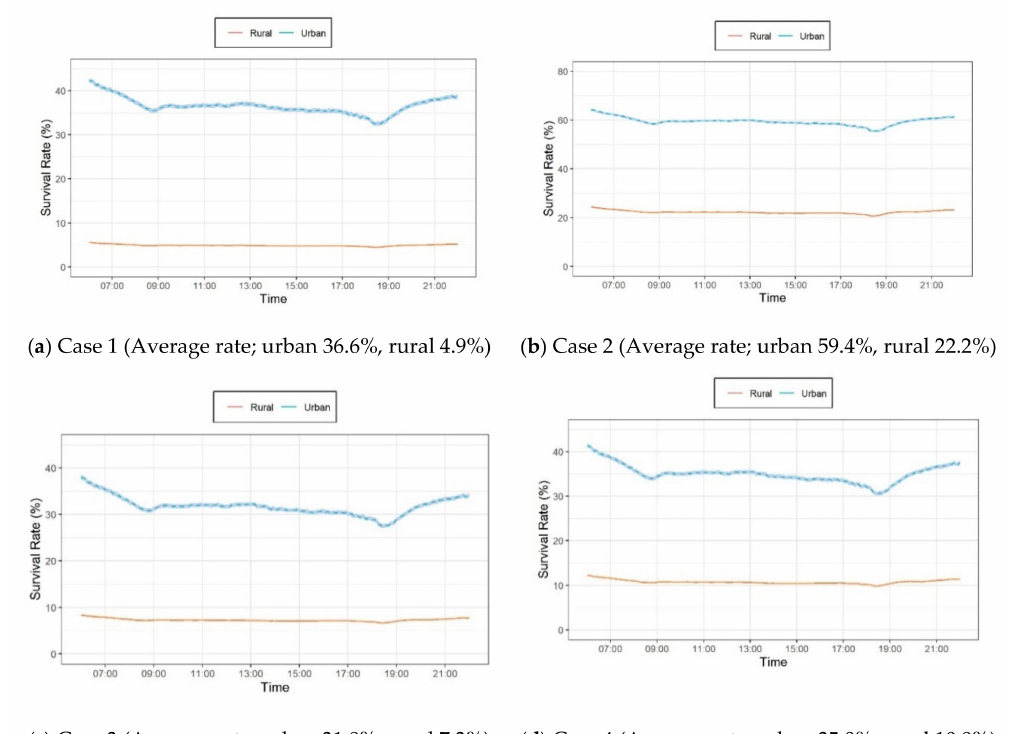
Figure 6. Survival rates in urban and rural areas by emergency response case. The survival rates in di ff erent timeslots are shown according to the emergency response cases described in Table 2. Among the four cases, the highest survival rate is Case 2, which is when a patient receives cardiopulmonary resuscitation (CPR) by someone near the